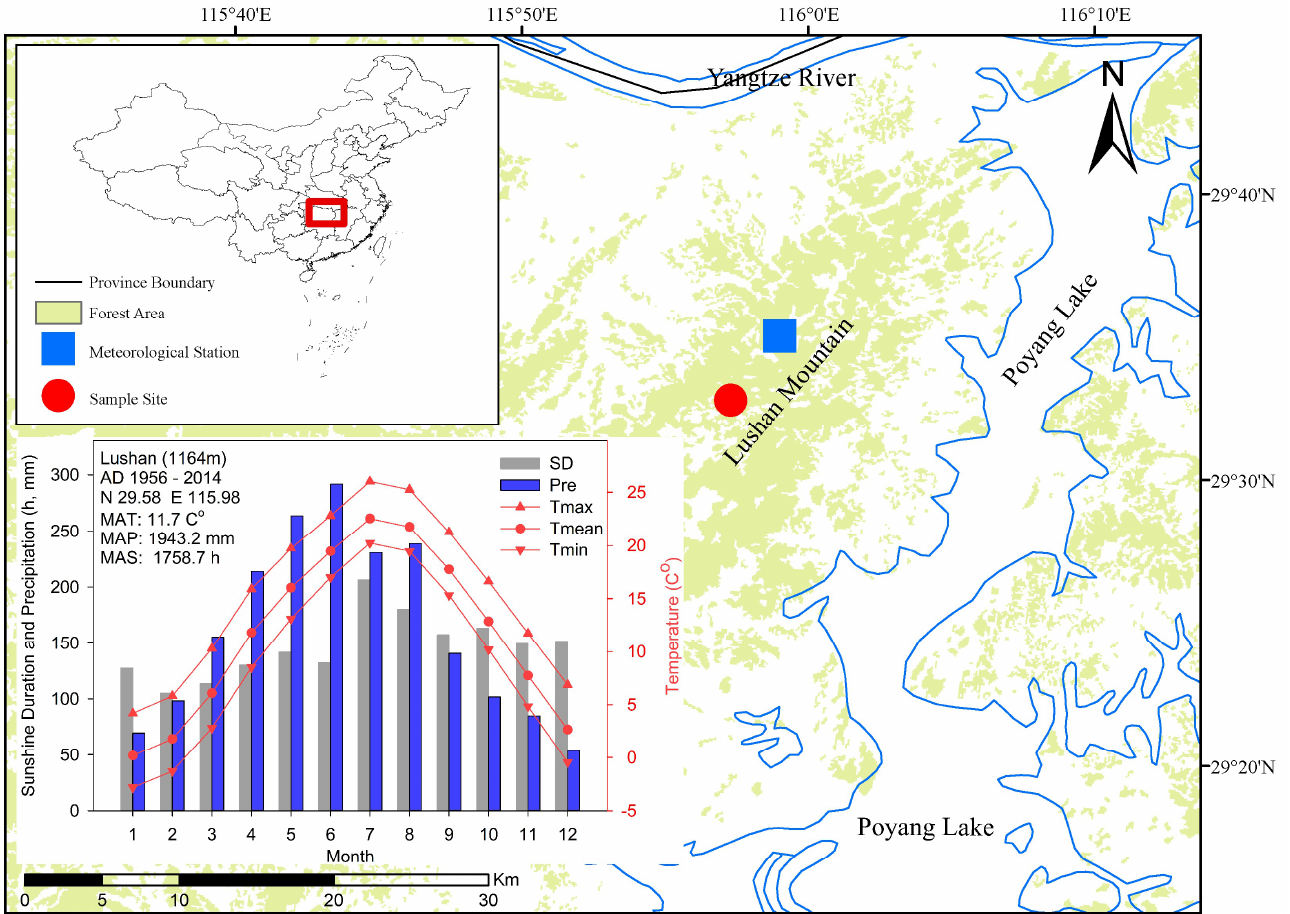
Figure 1. Sampling site and meteorological station locations and climate condition during 1955–2014 (small panel). MAT, mean annual temperature; MAP, mean annual precipitation; MAS, mean annual sunshine duration.